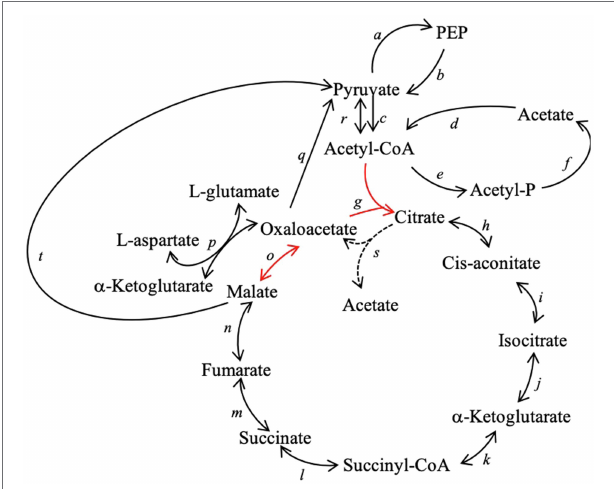
FIGURE 4 | Tricarboxylic Acid (TCA) cycle and related pathways in Ca. A. pyornia. Candidatus A. pyornia has an incomplete TCA cycle and is missing genes that code for two enzymes: citrate synthase and malate dehydrogenase (red arrows o and g ). Oxaloacetate can still be produced from L-aspartate and 2-oxoglutarate, and oxaloacetate can be decarboxylated to pyruvate. Acetate can be produced through multiple pathways, including the